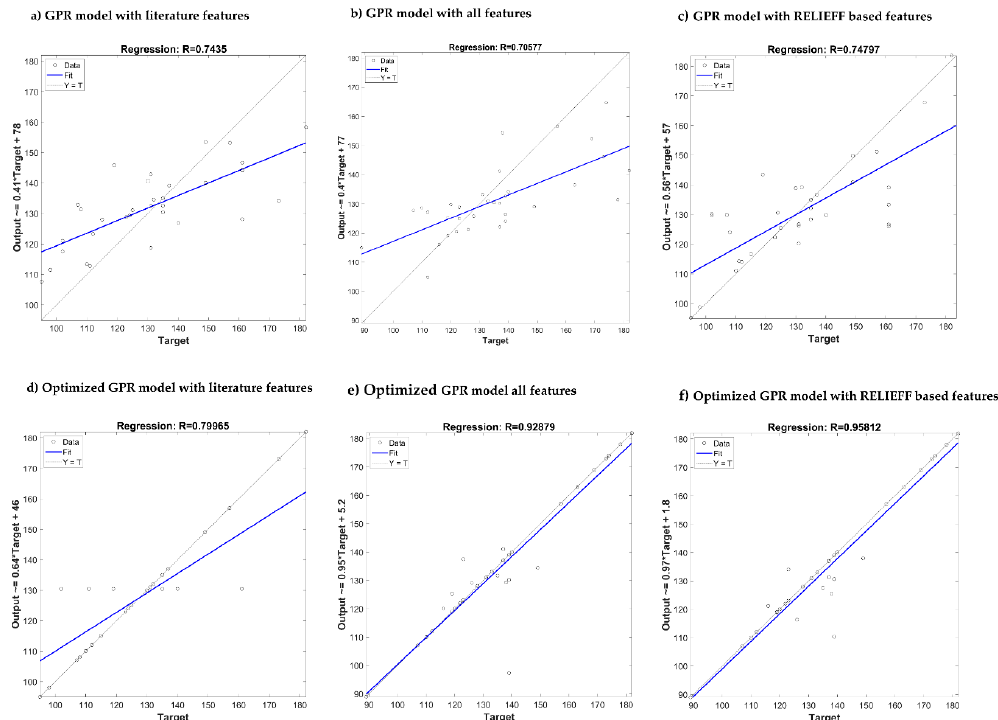
Figure 14. Comparison of the predicted output vs. actual target for SBP estimation using different GPR: ( a–c ) Models without optimization, ( d–f ) models with optimization.